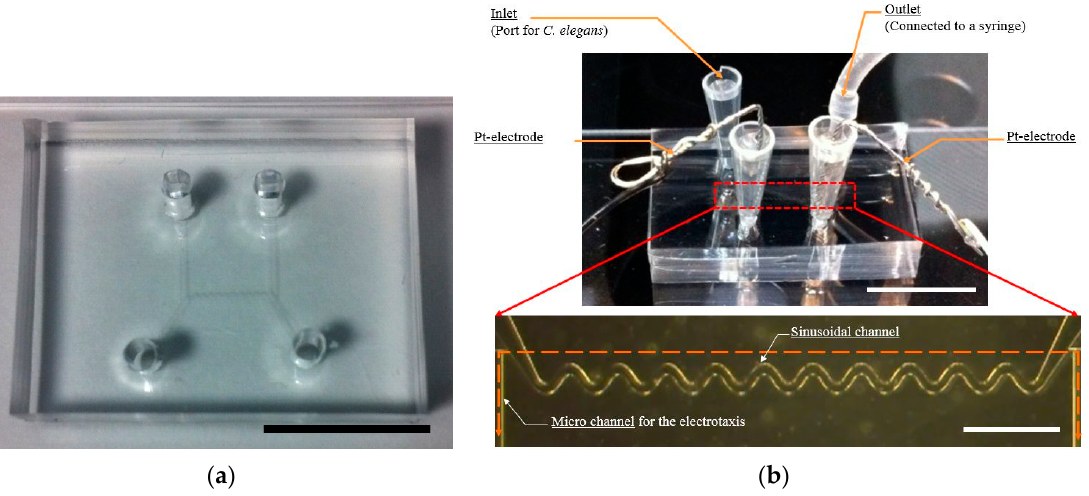
Figure 5. ( a ) Photograph of the microfluidic device for the electrotaxis test. Scale bar marks 1 cm. ( b ) Photograph of the experimental setup and a microscopic image of the sinusoidal channel. Electric current flowed following the micro channel (orange line). Scale bars mark 1 cm (top) and 1 mm (bottom).